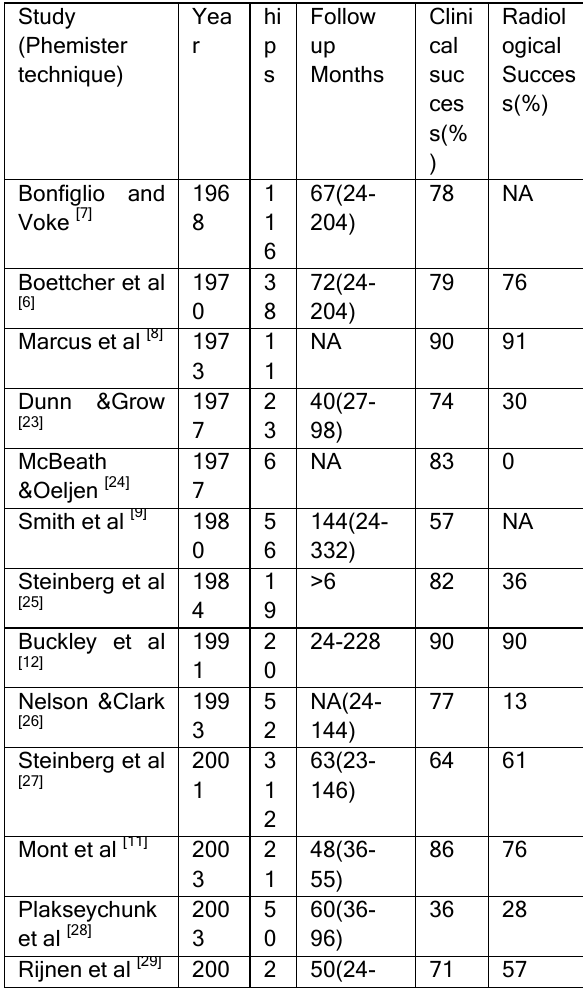
Table 5: Literature review of non vascularised bone grafting